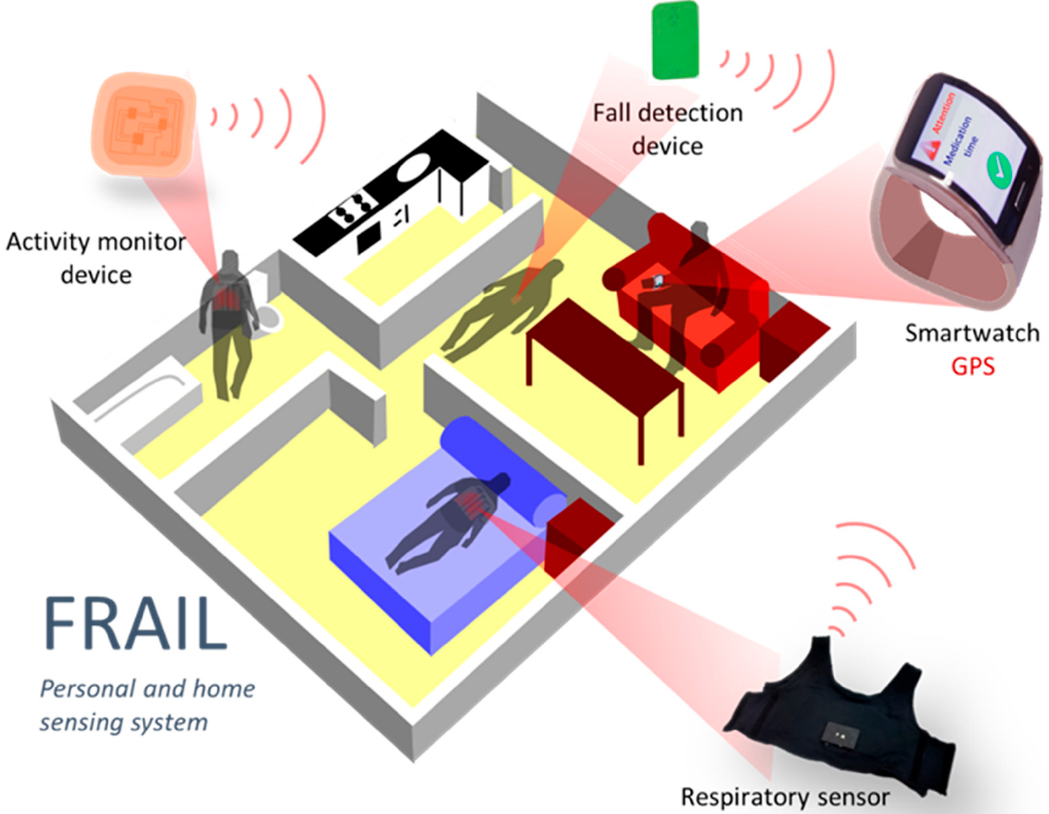
Figure 2. FRAIL Personal and home sensing platform.